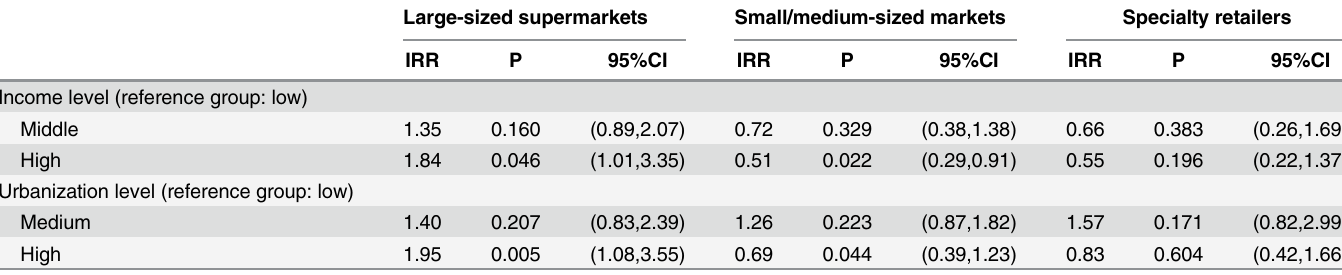
Table 3. Models of the relationship between the numbers of each type of food stores and city level of income and urbanization *